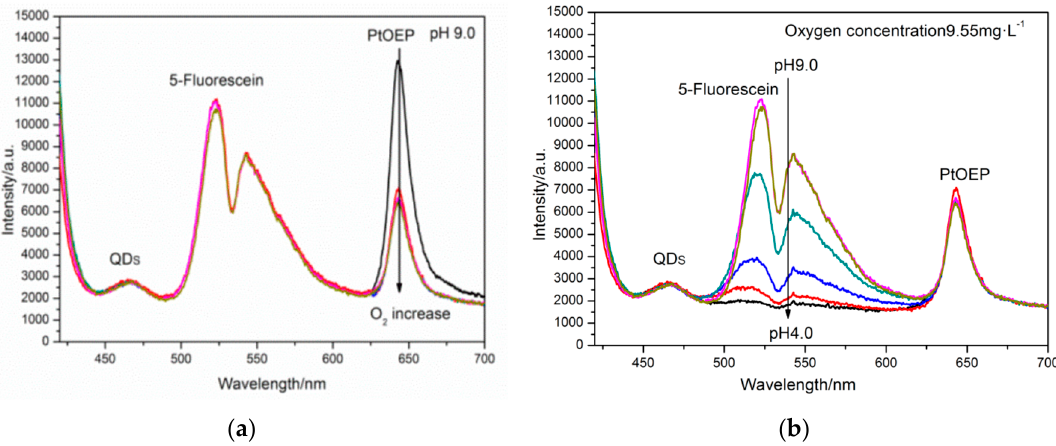
Figure 5. The emission spectra of ratiometric pH/oxygen planar optode:( a ) Emission spectra in different oxygen concentration at pH 9.0, the different colors of the lines represented the different oxygen concentration, and the arrow indicates the increasing of oxygen concentration; ( b ) Emission spectra at pH values between 4 and 9 under the oxygen concentration of about 9.55 mg·L − 1 , the different colors of the lines represented the different pH value, and the arrow indicated the decrease of pH.